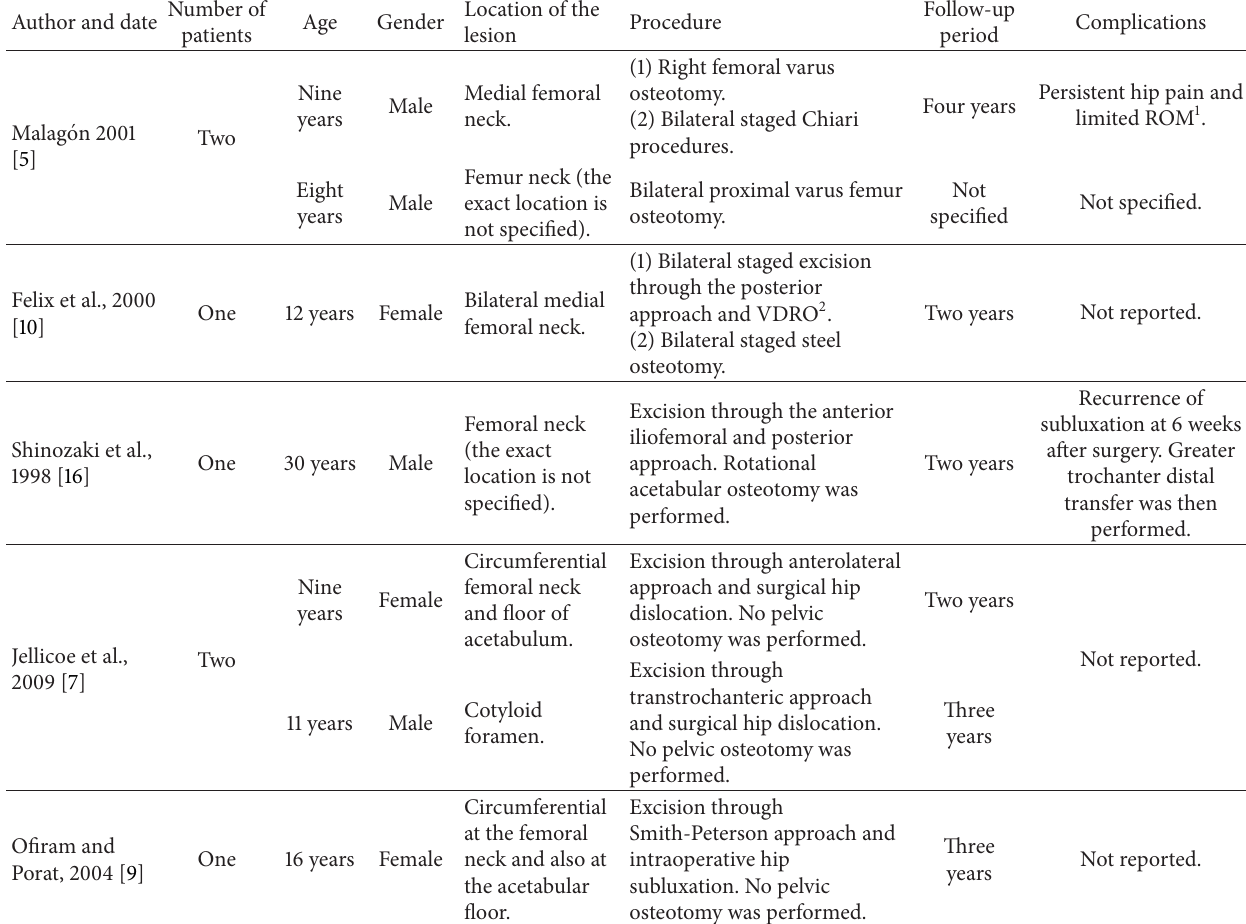
Table 2: Literature review. Surgical treatments for hip osteochondroma with acetabular dysplasia in previous studies. Number of Author and date